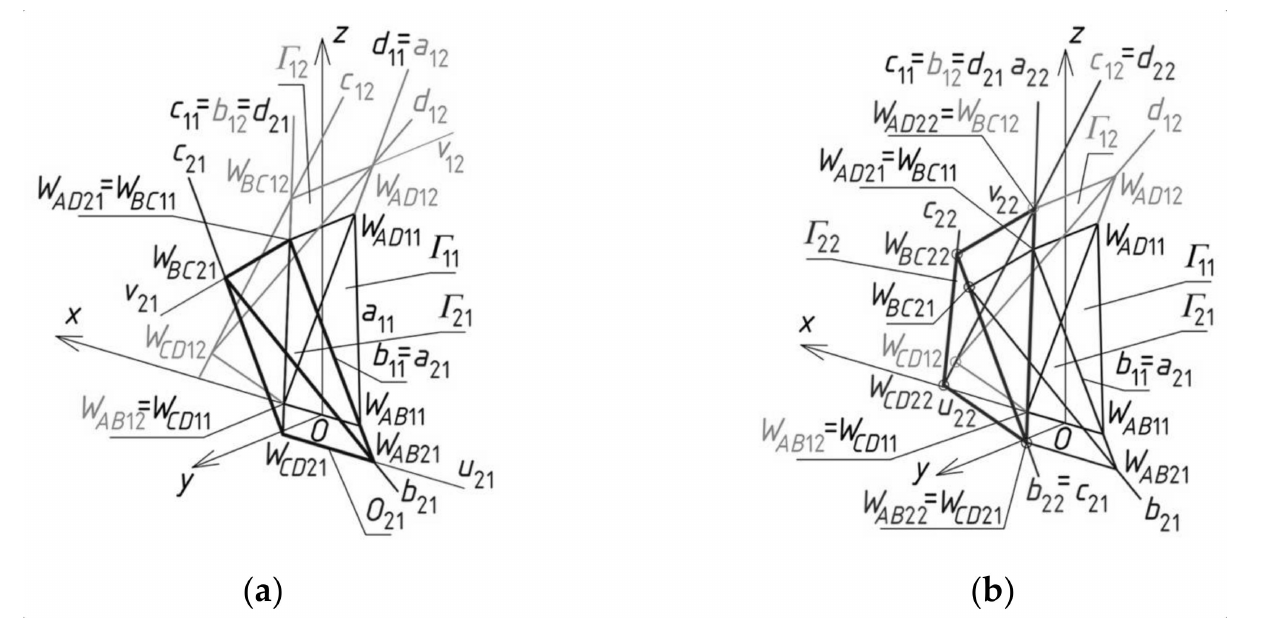
Figure 10. The results of further initial steps of the method’s algorithm used for creating Γ : ( a ) Γ 21 ; ( b ) Γ 22